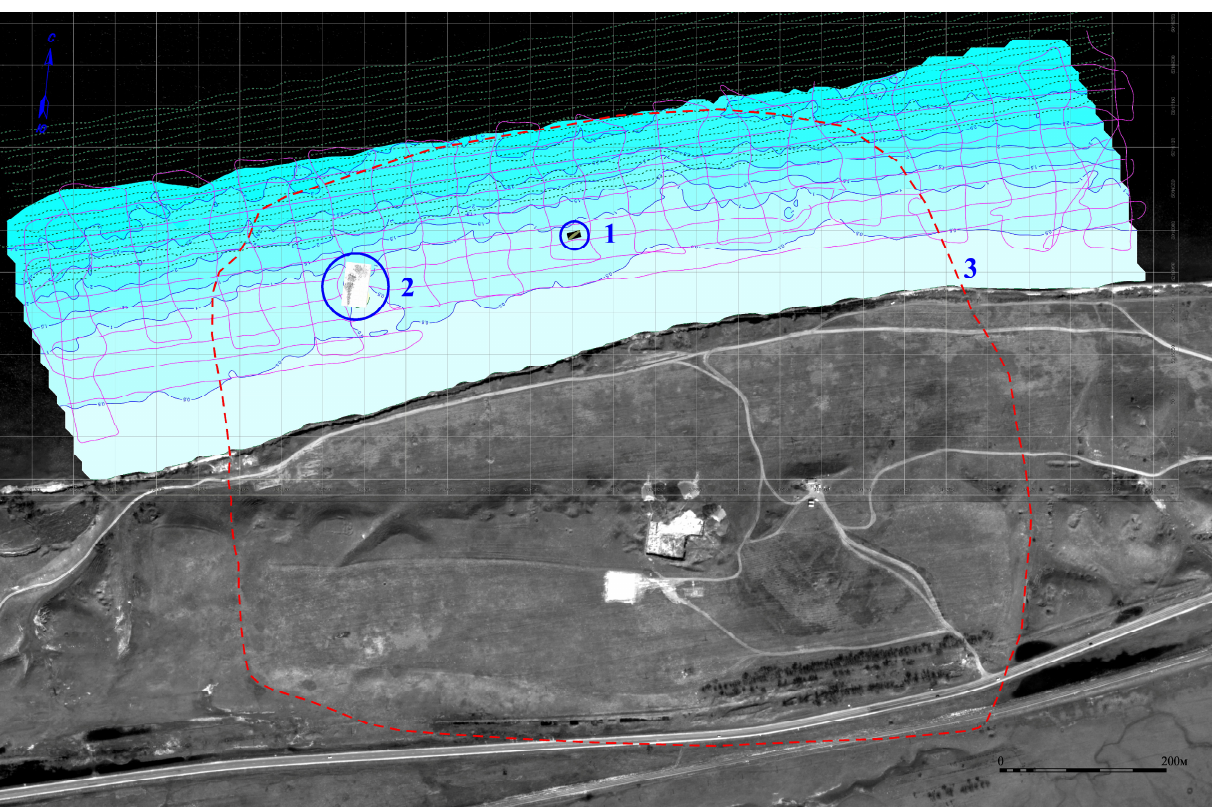
Figure 1. The ancient city of Phanagoria from space: 1. The Phanagorian shipwreck, 2. The excavated remains of the pier of the Roman period, 3. The city limits marked by cultural layers at their maximum extent. Background – WorldView-1 high resolution imagery.